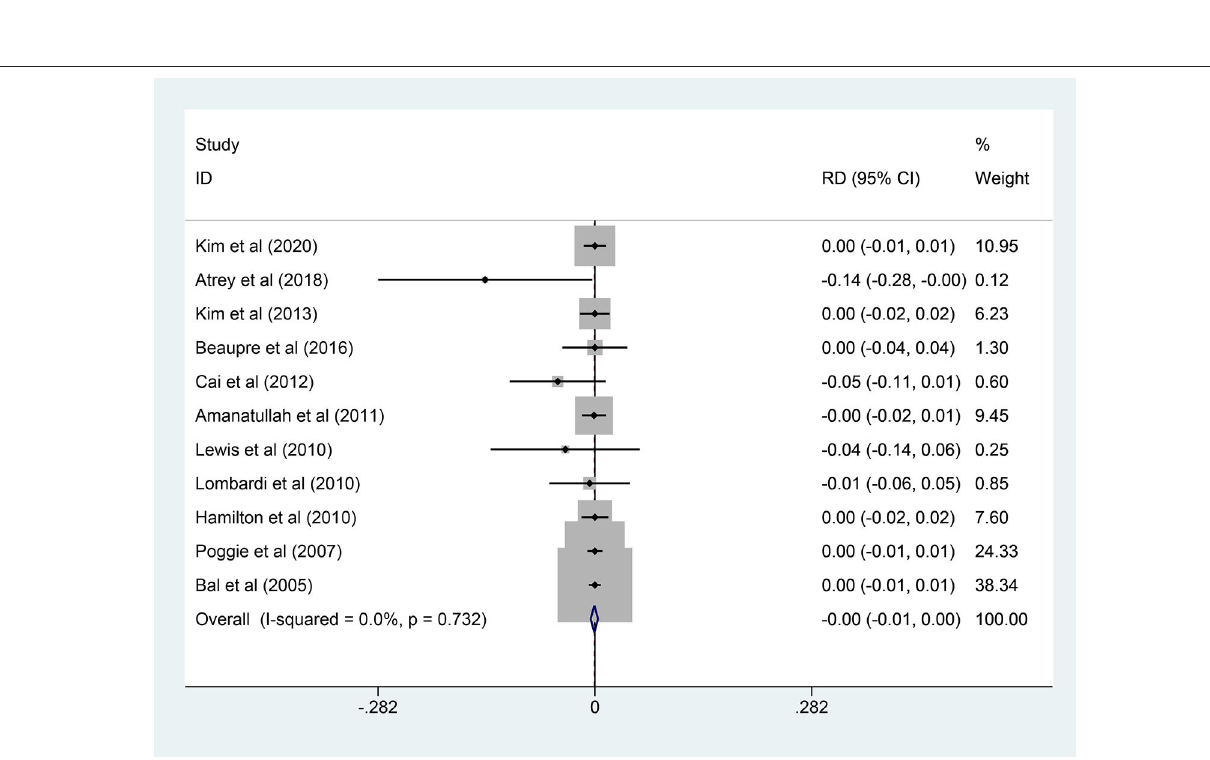
Frontiers in Surgery |